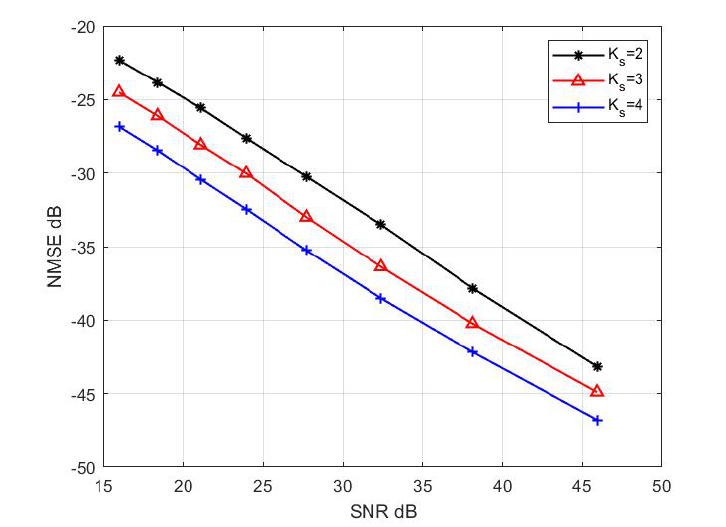
Figure 12. The effect of K s on the